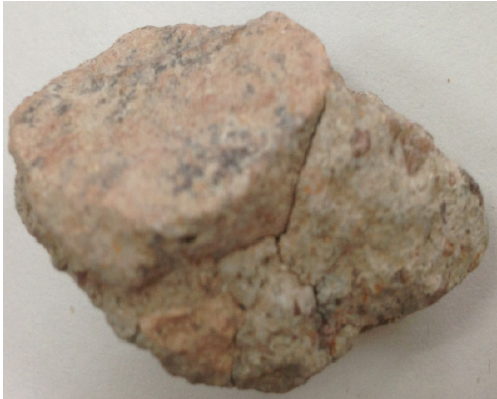
Figure 5. Aggregate morphology after calcination.